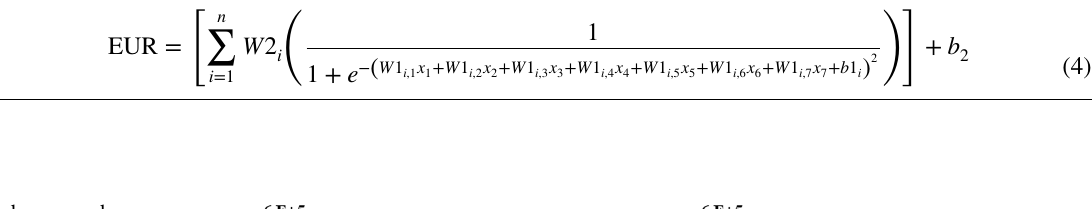
Fig. 12 The actual versus cal- culated EUR plot for the ANN model in the case of a the train- ing and b the testing data